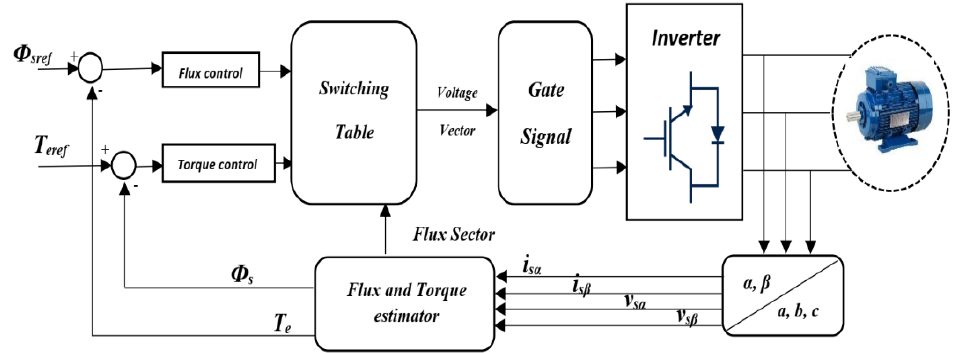
Figure 4. Direct torque control scheme.